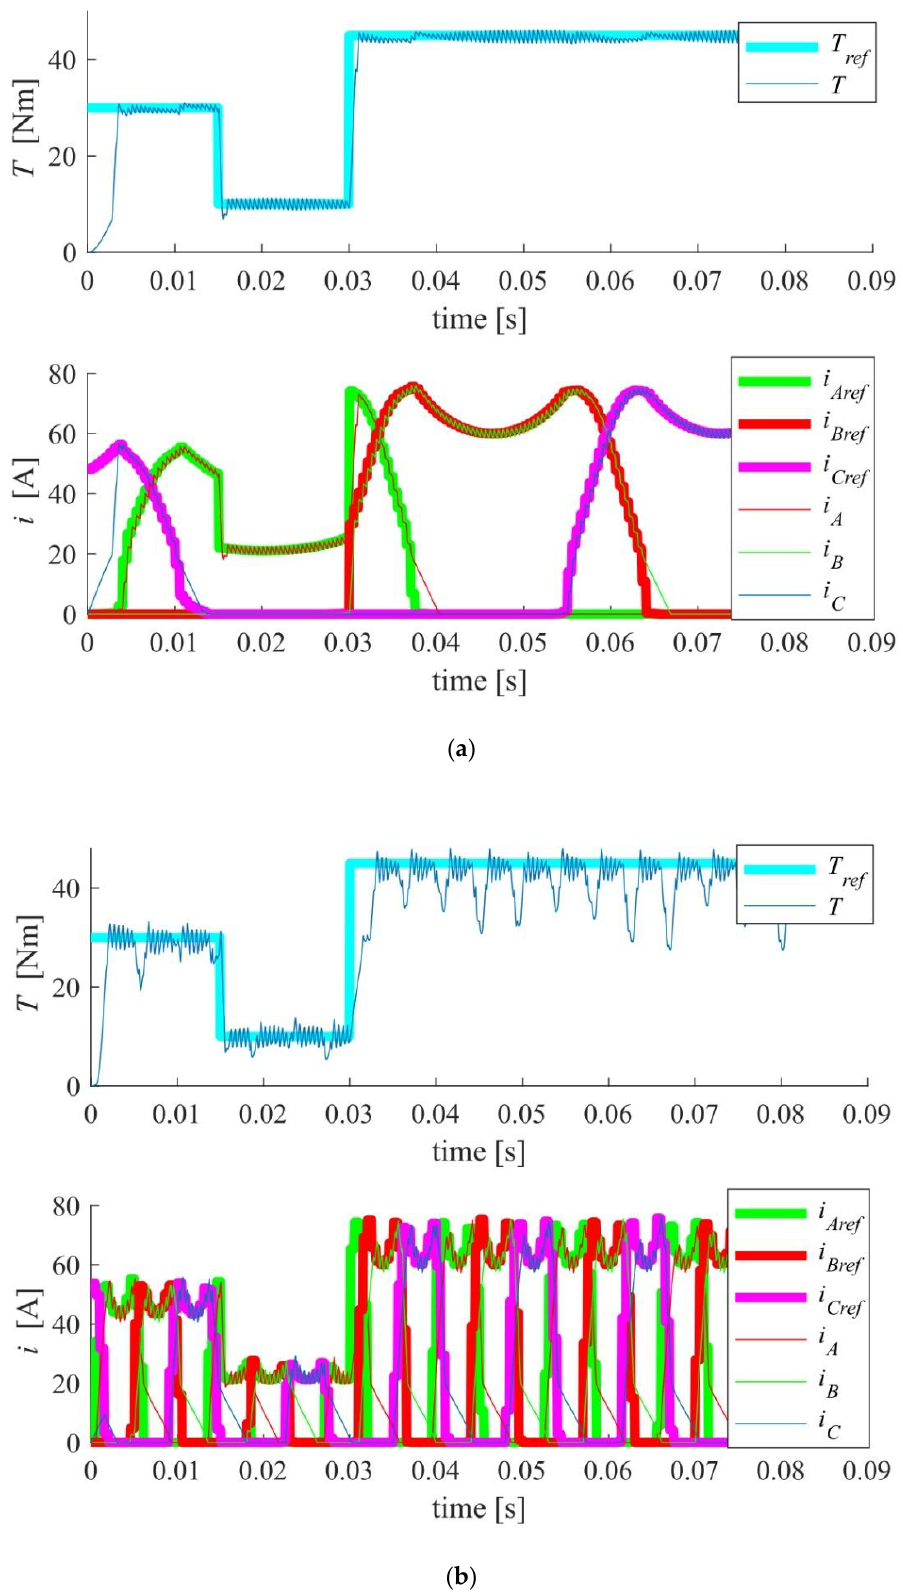
Figure 8. Operation at constant electrical speed: ( a ) 80 rad/s—mostly absent of voltage constraints; ( b ) 480 rad/s—operation with regular voltage constraints.